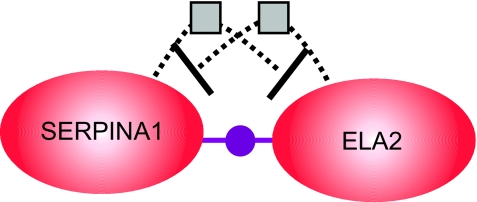
Pathway Assist™ diagram showing SERPINA1 and ELA2 relationships of Example 1. The protein products are indicated by the large ovals, a binding interaction is indicated by the purple dot relationship between the ovals, and gene expression regulation is indicated by a square along a dotted line.